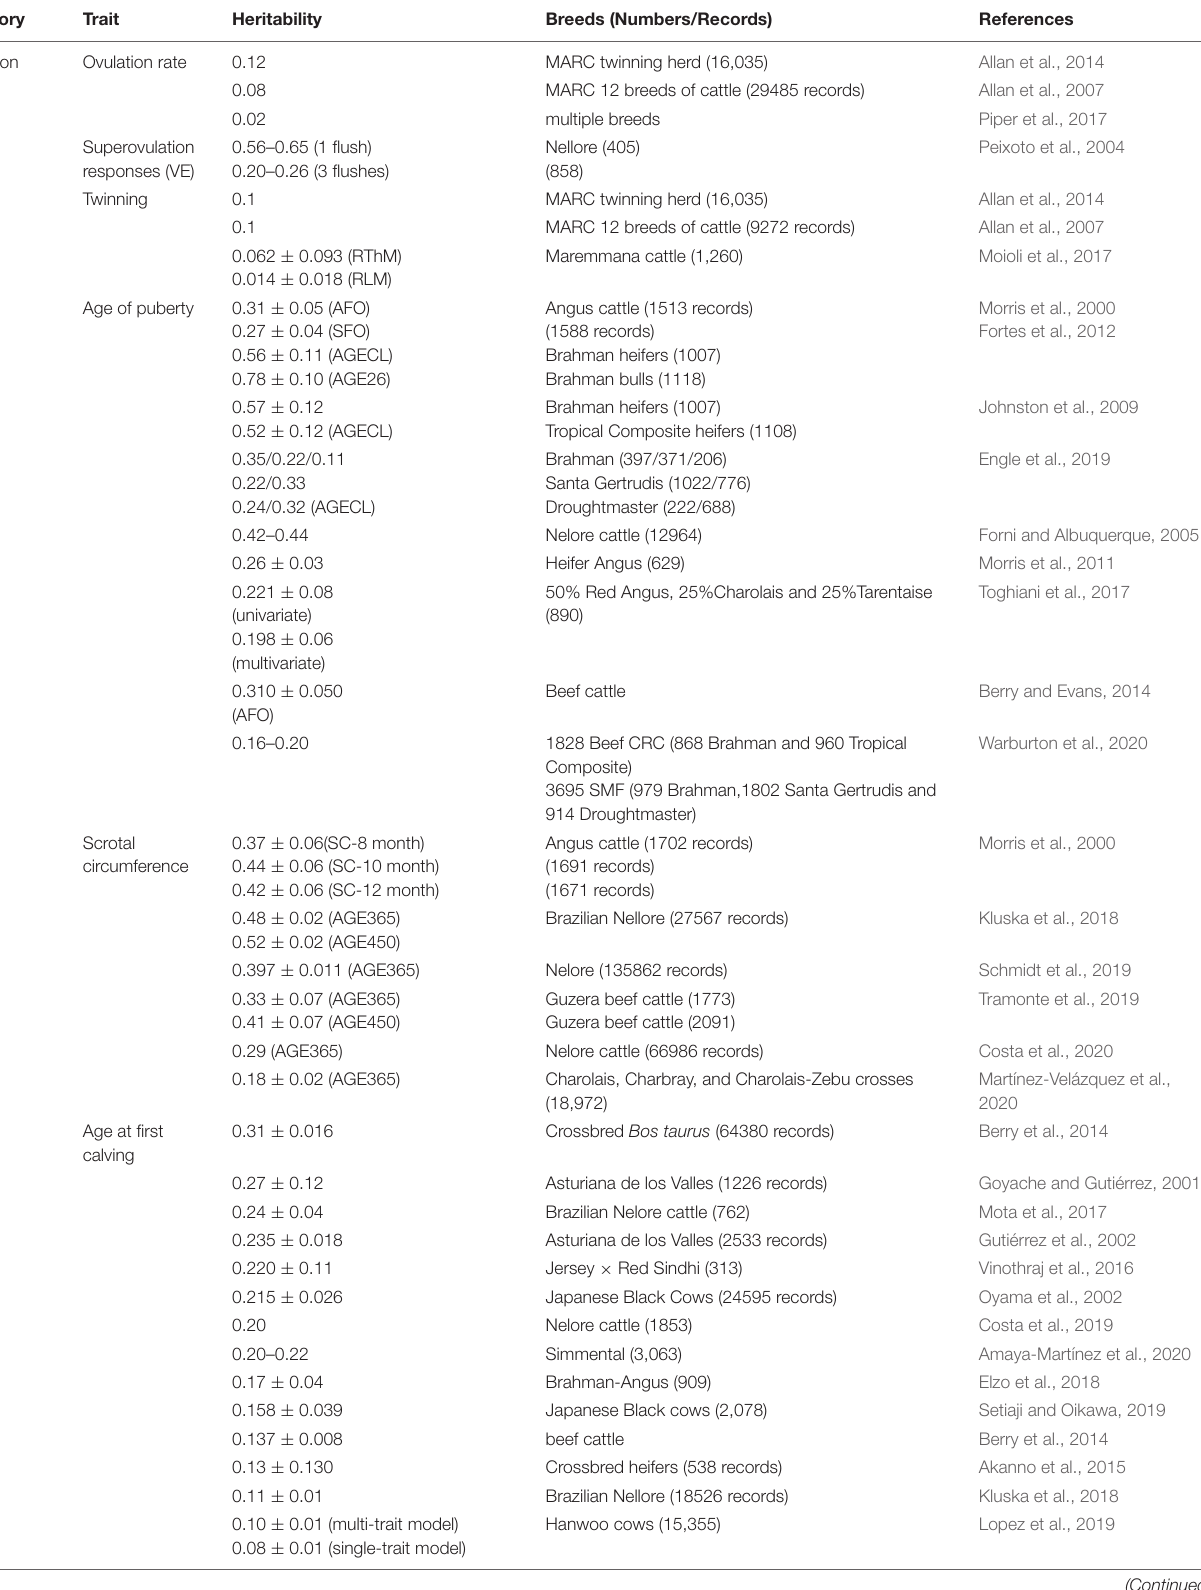
TABLE 3 | Heritability estimates of reproduction traits in beef